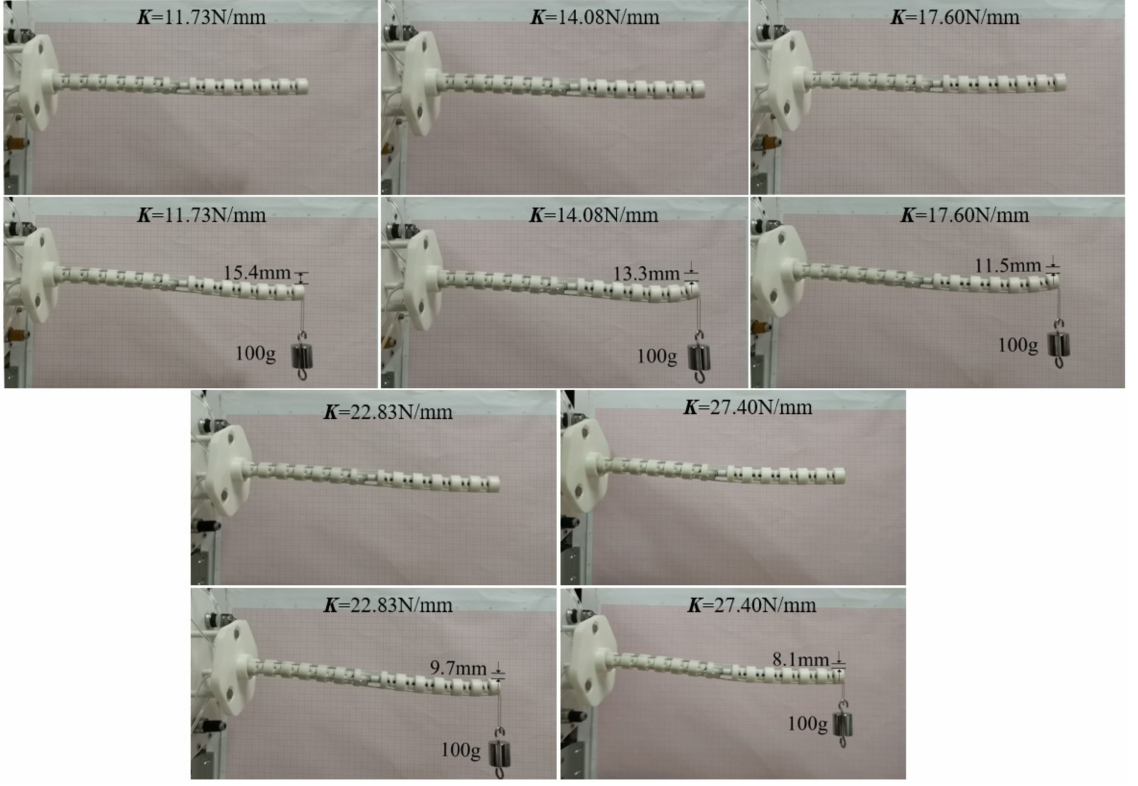
Figure 25. The 1 N load experiments on the distal segment with the straight